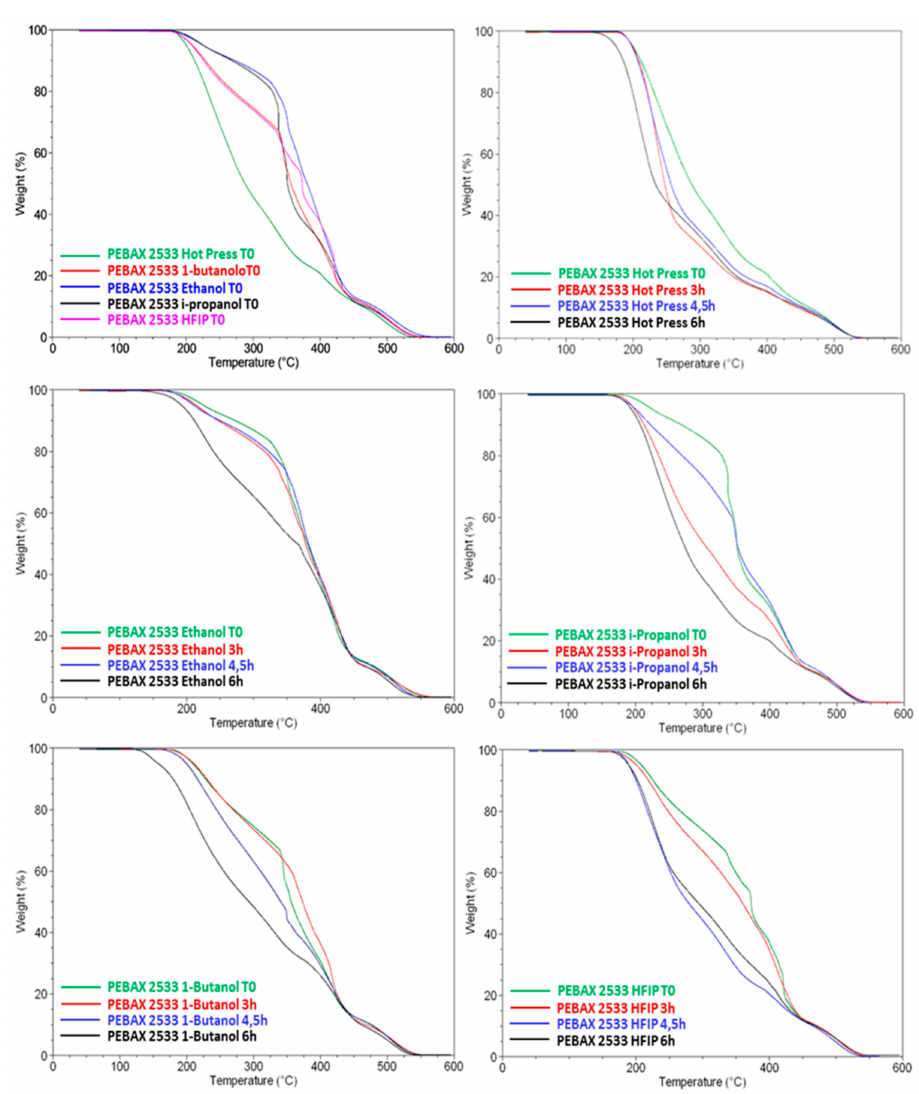
Figure 4. Thermogram overlays from Pebax ® 2533 films at T0 and after 3, 4.5, and 6 h of photo-oxidative